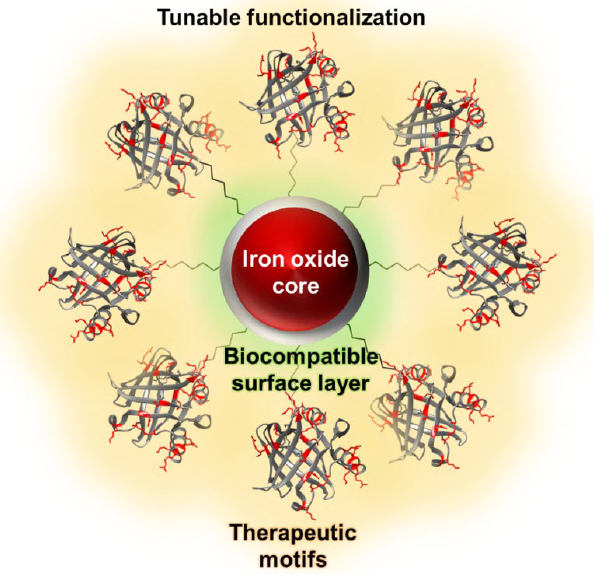
Figure 1. Schematic for tunable magnetic tracers for Alzheimer’s disease theragnostic tools. The magnetic core of the nanoparticles provides the detection capability for magnetic resonance imaging (MRI) with the functionalized biologics bestowing the therapeutic capability.